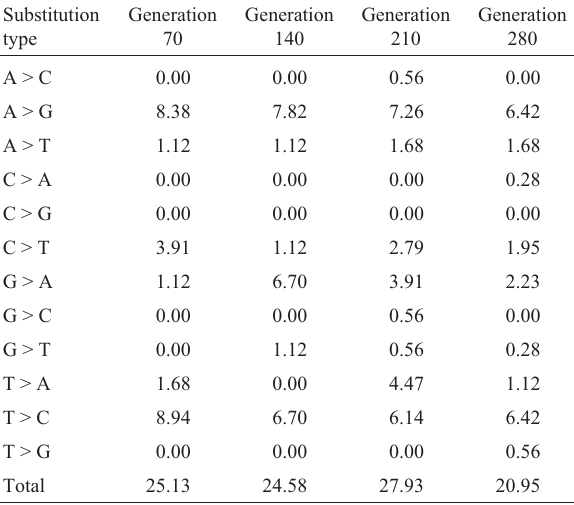
Table 1 - Observed substitutions at different time points along the experimental evolution phylogeny described in (Sanson et al. , 2002). Numbers in the table represent the number of substitutions per 10